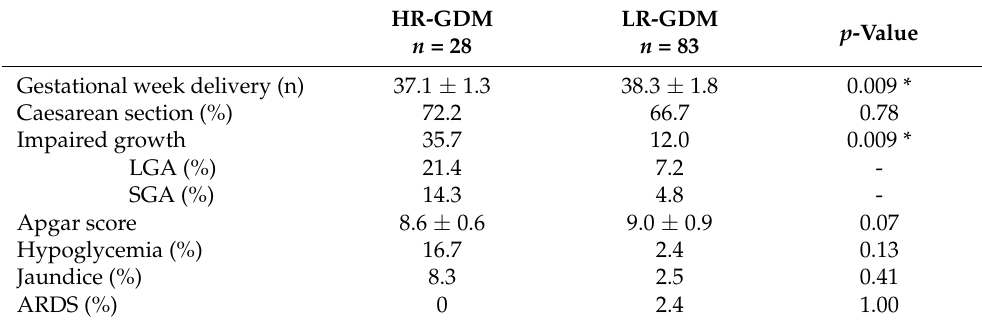
Table 4. Neonatal parameters and pregnancy